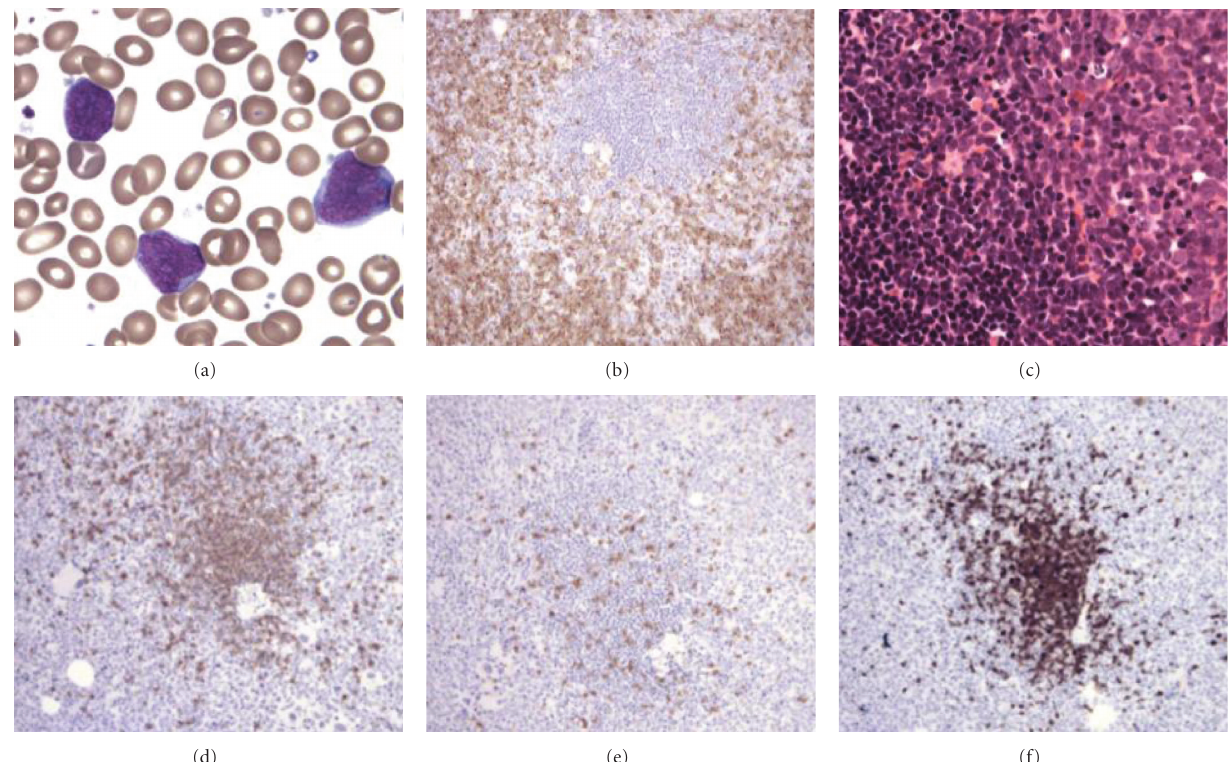
Figure 3: Acute myeloid leukemia and associated bone marrow involvement by mantle cell lymphoma: (a) peripheral blood smear, Wright- Giemsa stain, blasts, Ob. 100x, immersion oil. (b) Bone marrow biopsy, Ob. 20x, anti-CD34 antibody highlights positive blasts; the lymphoid cells are negative. (c) Bone marrow biopsy, hematoxylin and eosin stain, Ob. 50x, lymphoid aggregate and blasts. (d) Bone marrow biopsy, anti-CD20 antibody highlights a large subset of positive cells in a lymphoid aggregate, Ob. 20x. (e) Bone marrow biopsy, anti-CD3 antibody highlights a small subset of positive cells in a lymphoid aggregate, Ob. 20x. (f) Bone marrow biopsy, anti-Cyclin D1 antibody highlights a large subset of positive cells in a lymphoid aggregate, Ob.